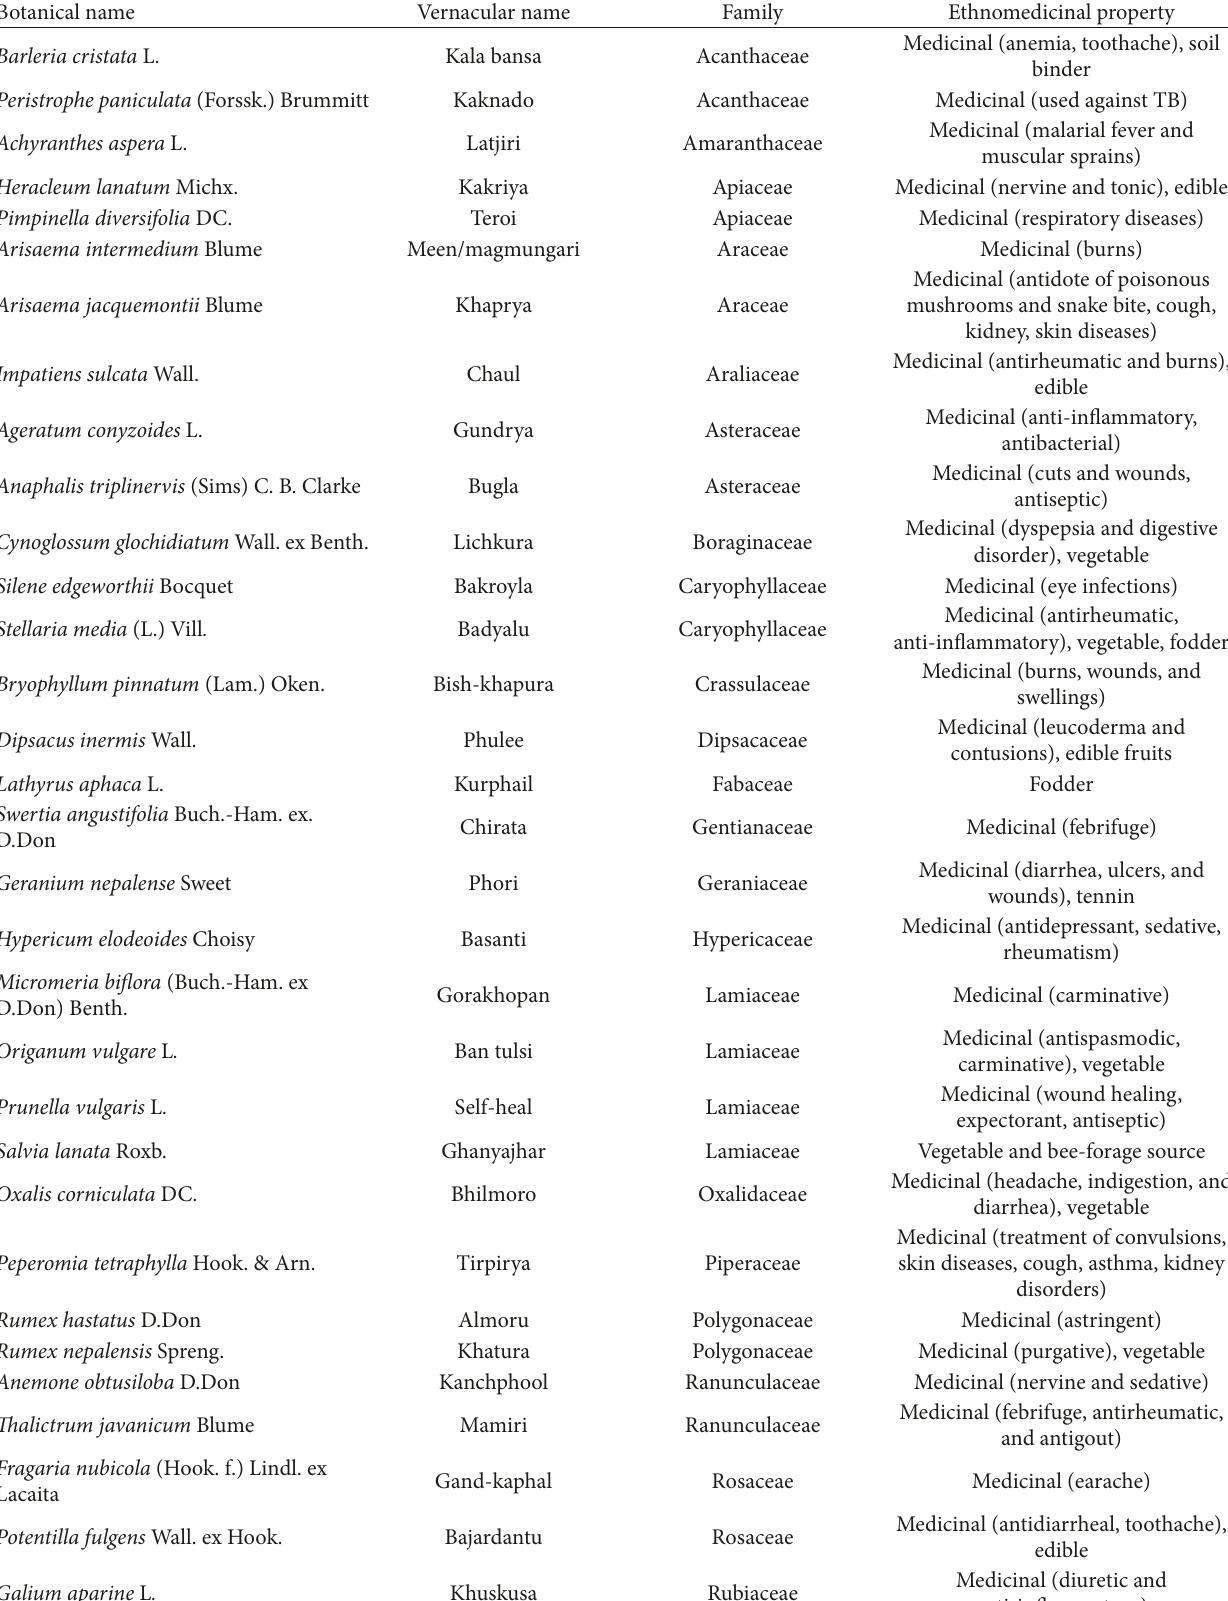
Table 4: List of Herbaceous species (with ethnomedicinal properties) found in Hariyali Devi